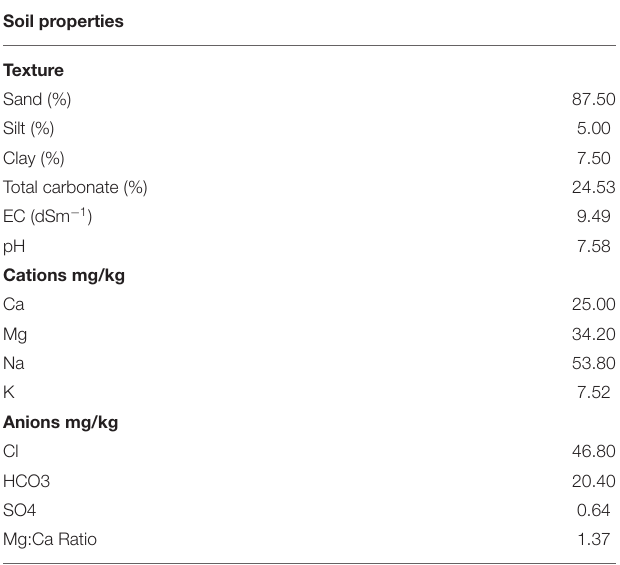
Table 1 | Physicochemical properties of planting